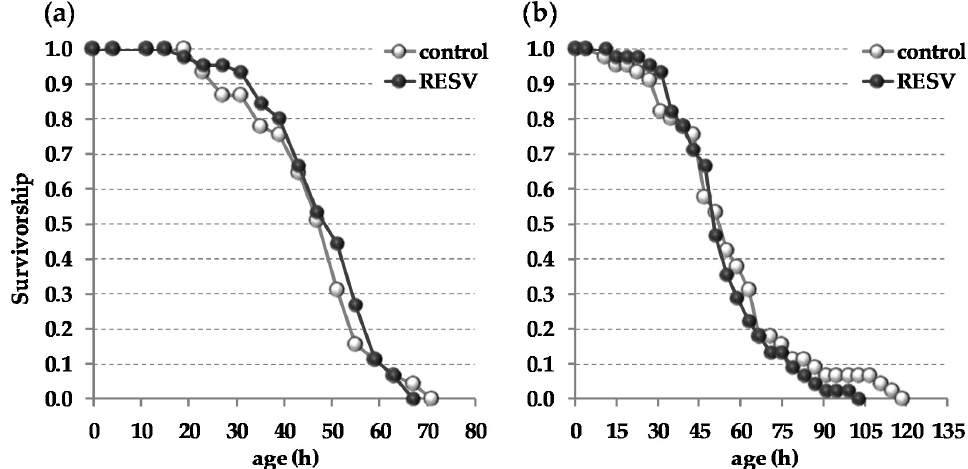
Figure 3. Dietary resveratrol (RESV; 500 µmol/L) does not improve stress resistance of w 1118 D. melanogaster against reactive oxygen species. Flies received a resveratrol-supplemented or a control diet for ten days prior to the exposure to hydrogen peroxide (10% w / v diluted in a 5% w / v sucrose solution). Dead flies were steadily counted every four hours. ( a ) Survival curve of male and ( b ) female flies. The stress resistance experiment was independently performed three times with 45 flies/group each revealing similar results. Statistics: Log-Rank.